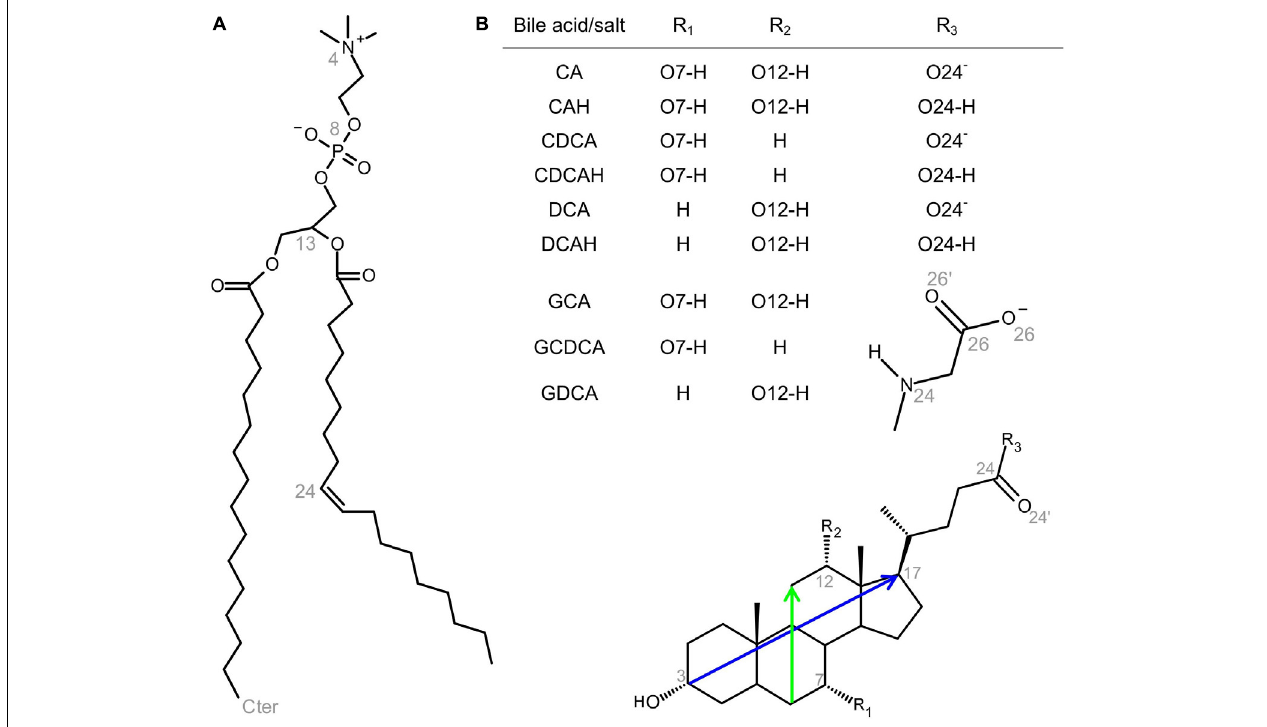
FIGURE 1 | Structures of POPC (A) and BS addressed in this study ( B ; see also inset table for definition of R 1 , R 2 , and R 3 for the different BS species), showing the numbering of selected atoms pertinent to the simulations, as well as the definition of the long and short molecular axes of BS (blue and green,